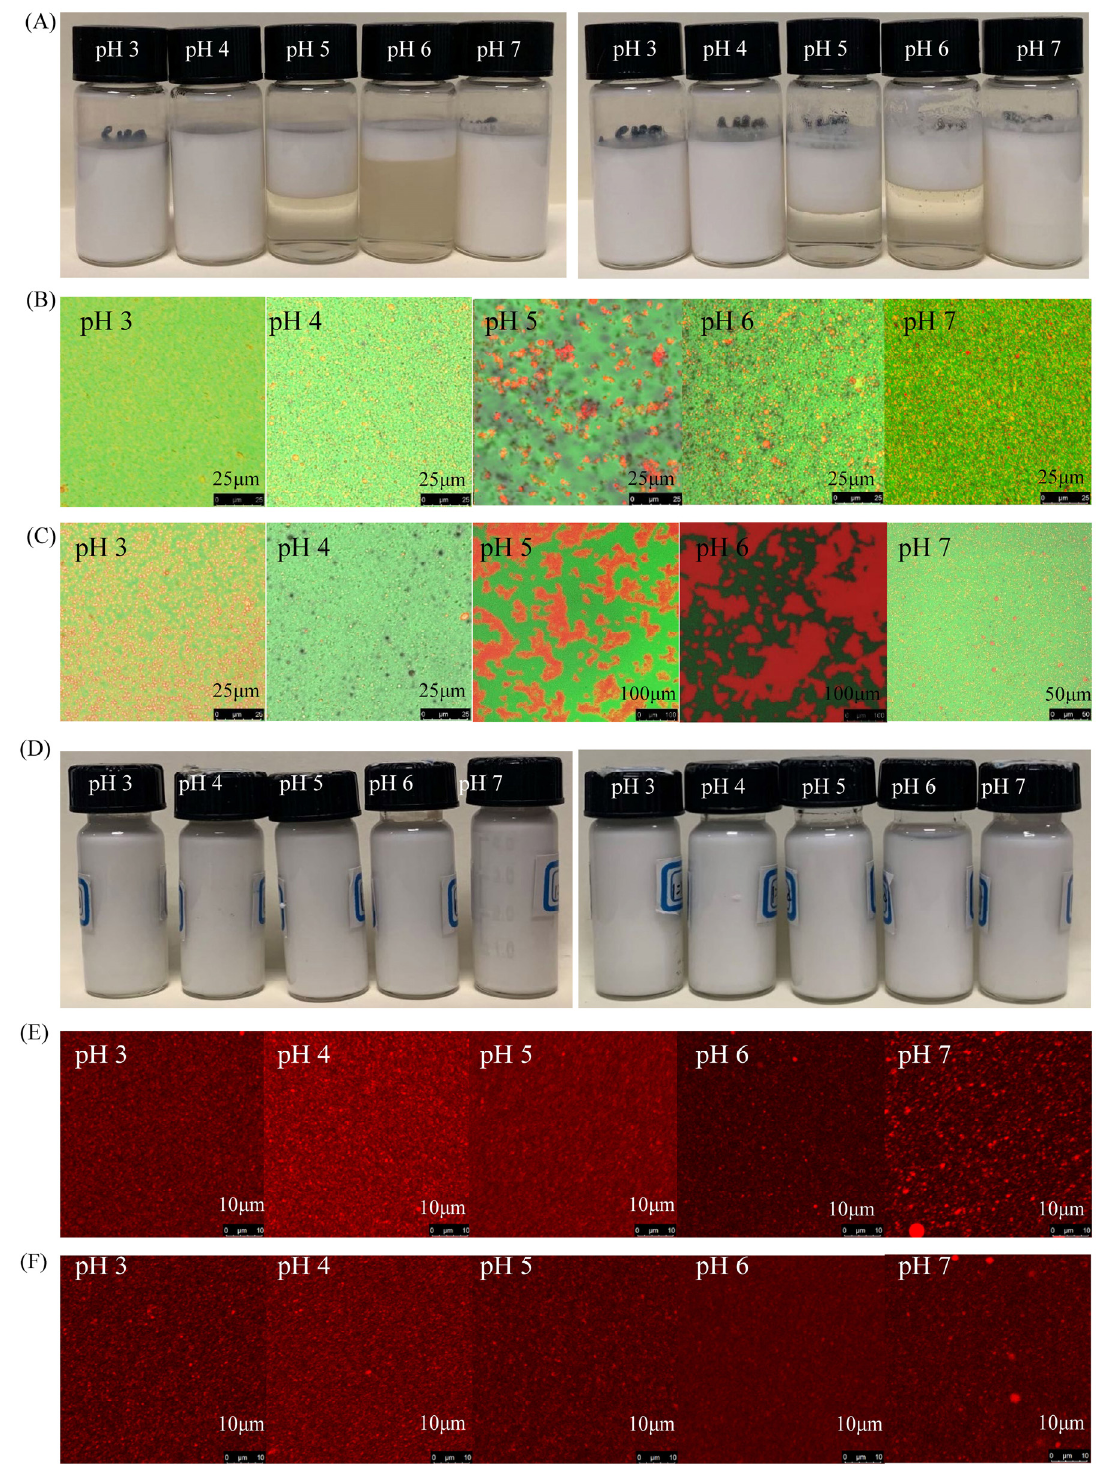
Figure 3. Visual observation and CLSM images of emulsions stabilized by PAs and PA/DS at different pH values. ( A , D ) Visual observation of PAs and PA/DS emulsions, respectively (left row, unheated; right row, heated). ( B , C ) CLSM images of PAs emulsions with unheated and heated treat- ments, respectively. ( E , F ) CLSM images of PA/DS emulsions with unheated and heated treatments, respectively. For ( E , F ), the oil phase is shown so as to clearly capture the changes in the oil